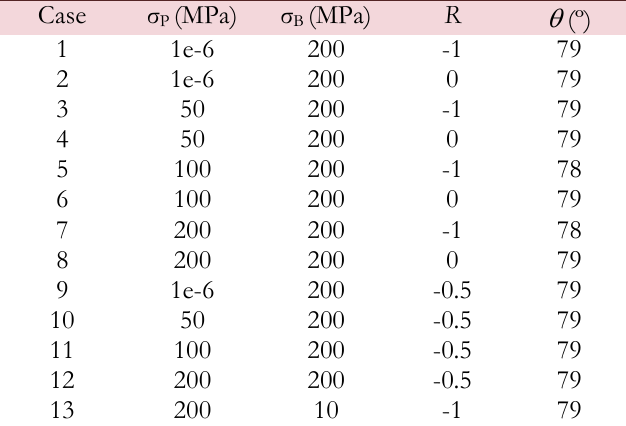
Table 1: Predicted orientation angles for different load cases, generated by variation of  P ,  Bulk and R .